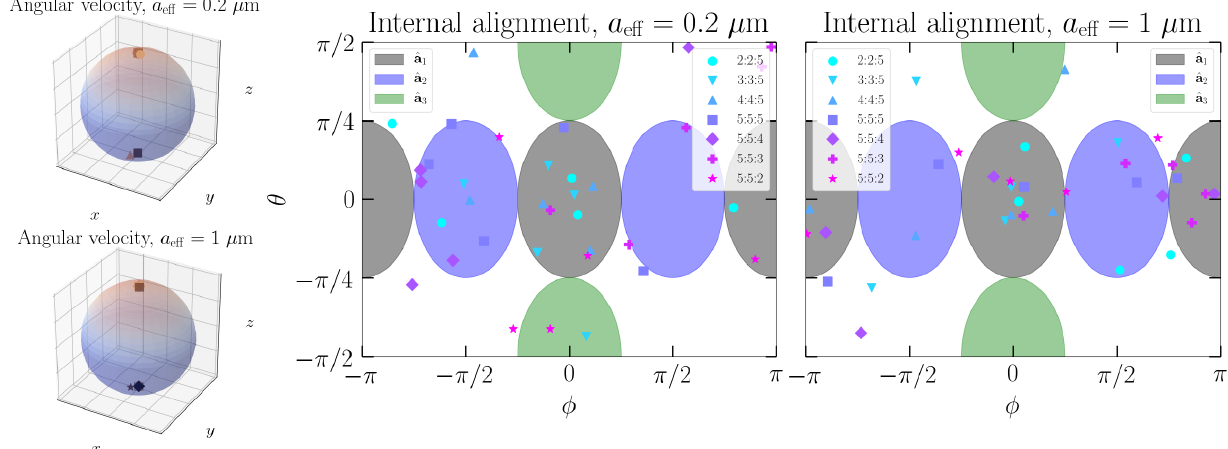
Fig 11. The directions of angular velocity for the 0.2 and 1 μ m samples in laboratory coordinates, where k k z for the beam, and the corresponding internal alignment of angular momenta. In body coordinates, the origin corresponds to the direction of principal axis of smallest moment of inertia (minor axis ^ a , grey), and ( ϕ , θ ) = (0, π /2) the direction of the major principal axis ( ^ a 1